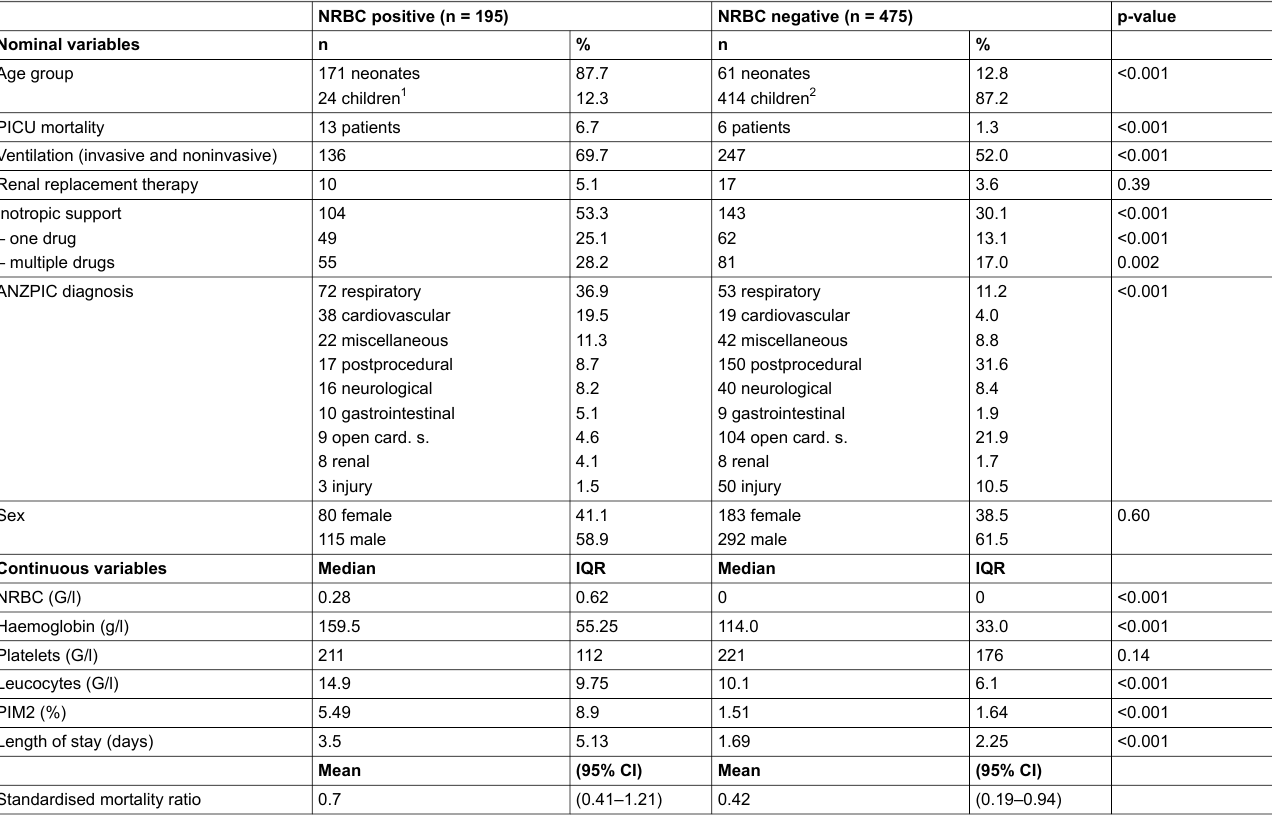
Table 1: Demographic, diagnostic, severity of illness and outcome data (outcome data referring to the entire stay at PICU) and haematological parameters (on the first day of admission) in NRBC-positive and NRBC-negative patients. For nominal variables, we provide absolute (n) and relative (%) frequency. For continuous variables, we provide median and interquartile